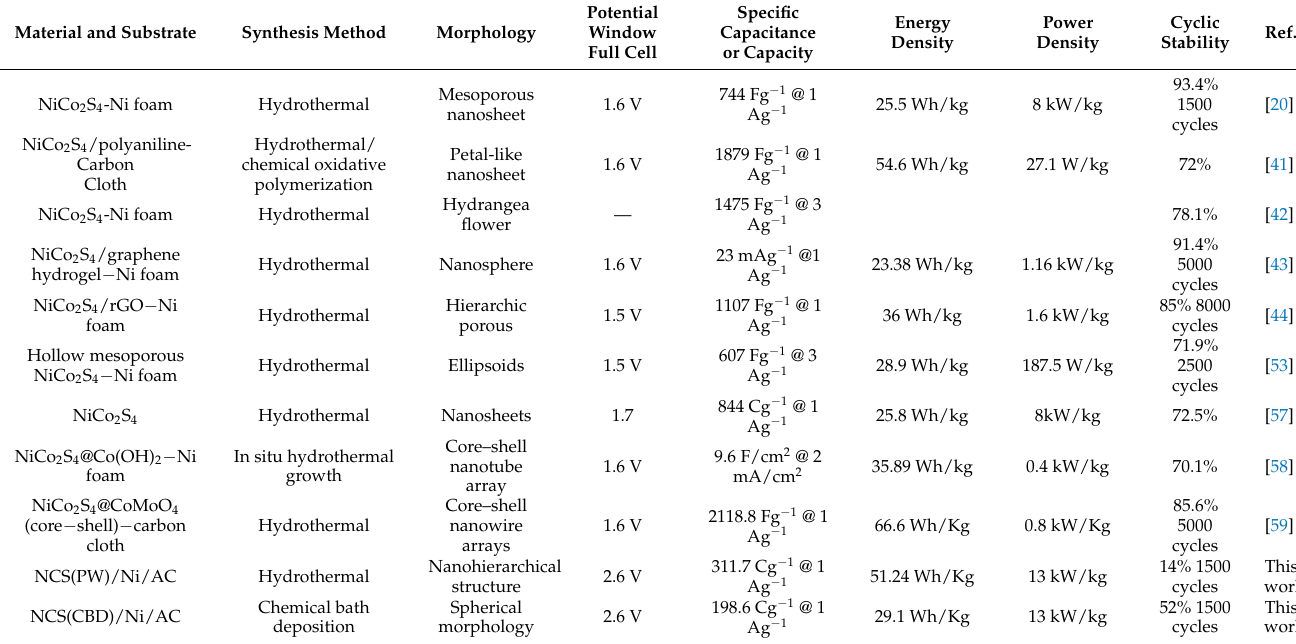
Table 1. Comparisons of the present work with previously reported NiCo 2 S 4 -based